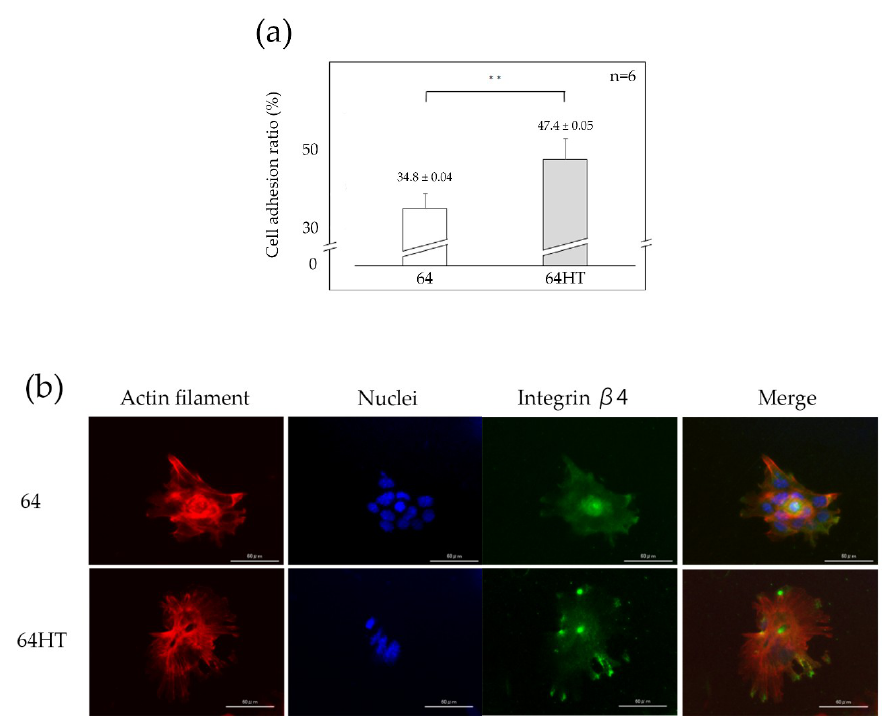
Figure 5. ( a ) Adhesion assay of GE1 cells. Data are shown as the mean ± SD. Statistical analysis was by t -test (** p < 0.01). ( b ) Immunofluorescence staining of GE1. Actin filaments (red), nuclei (blue), and integrin β4 (green) are shown (bar = 60 µm).